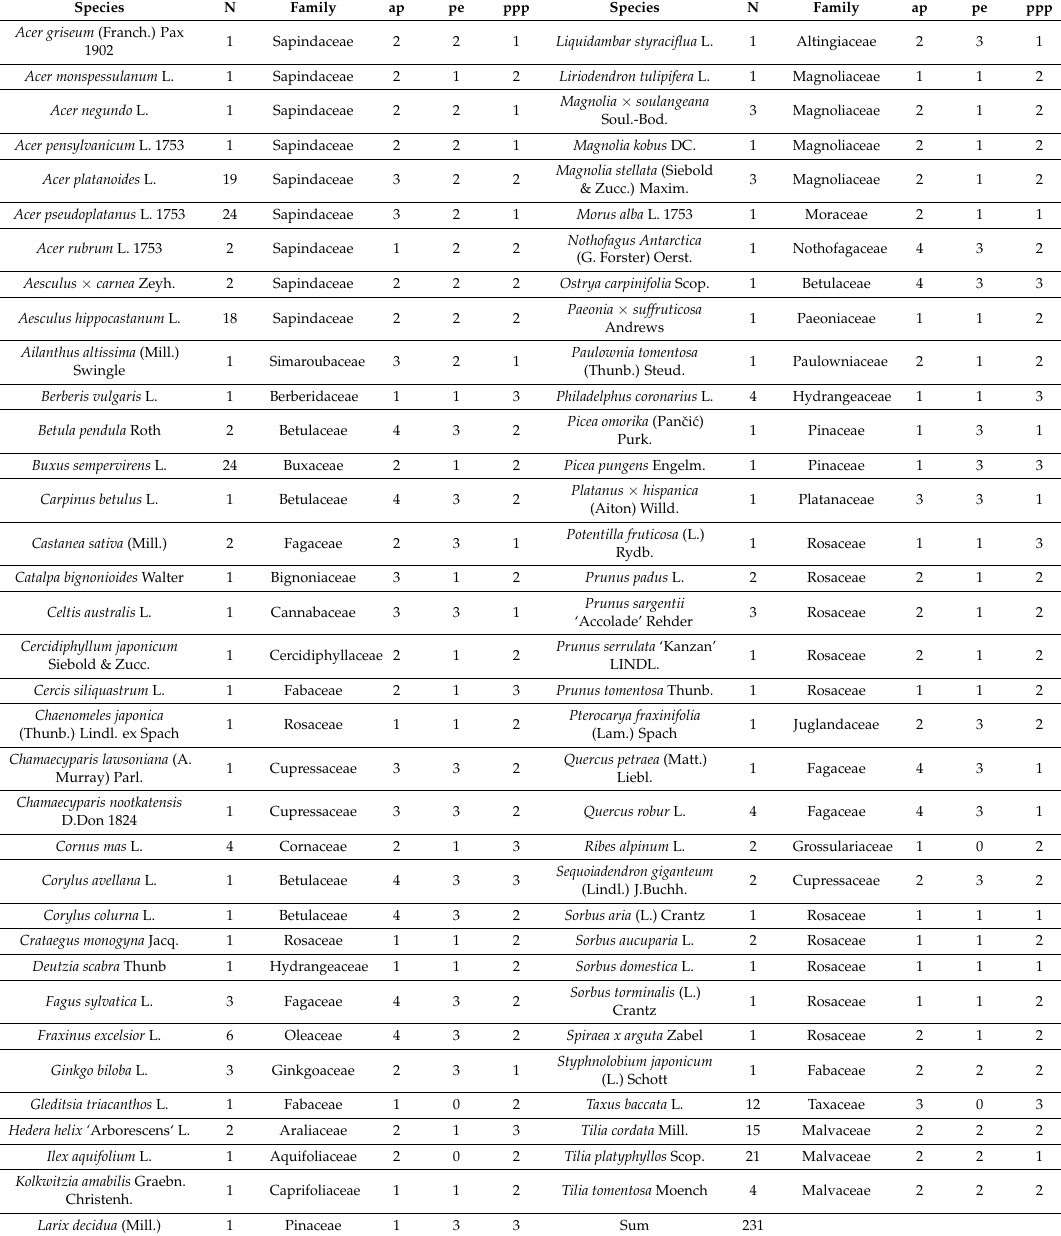
Table 1. Number ( N ) of individuals planted in Hofgarten belonging to 69 species and 31 plant families (according to the APG system [21]). ap: allergenic potential, pe: type of pollen emission, ppp: duration of principal pollination period (see Table 2 for parameters and values).